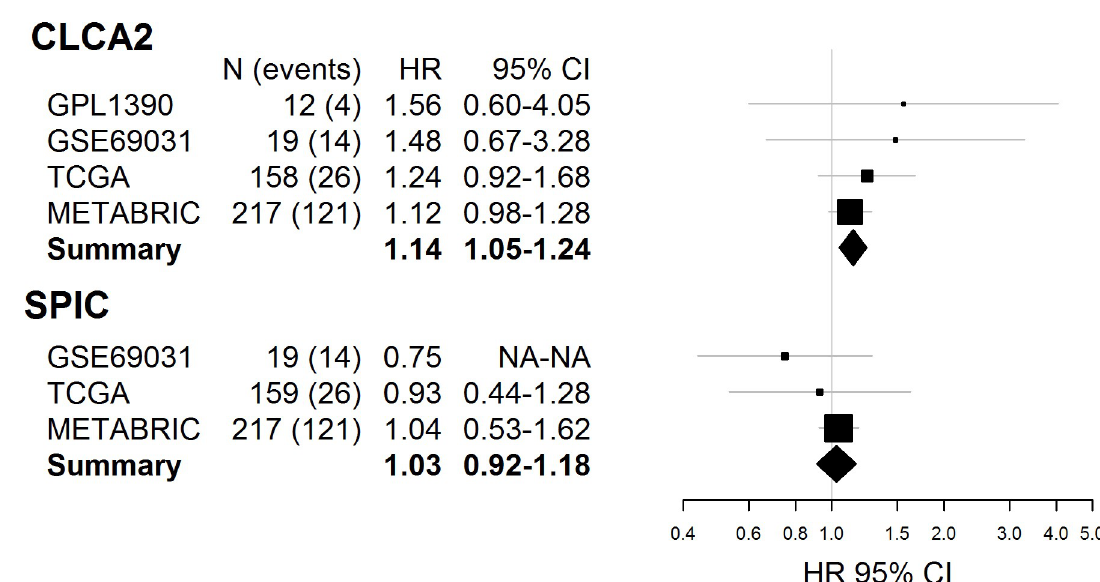
Fig 2. Forest plots for validation cohort analyses of CLCA2 , SPIC , and overall survival. Forest plots for analyses of GSE35629-GPL1390, GSE69031, TCGA, and METABRIC are shown for CLCA2 and SPIC . Only overall, rather than race-specific, analyses are shown because of small sample size (GPL1390, GSE69031) or lack of race data (METABRIC). All estimates are adjusted for age and stage at diagnosis. Study-specific hazard ratios (HR) are denoted by black boxes and 95% confidence intervals (CI) are denoted by corresponding black lines. Box heights are inversely proportional to precision of the HR estimate as influenced by sample size, such that a larger HR box indicates larger sample size and better precision. Summary estimates are denoted as diamonds, where the width of the diamond corresponds to the 95% CI. Estimates with confidence intervals that do not overlap the null line at 1.0 indicate significance at p < 0.05.